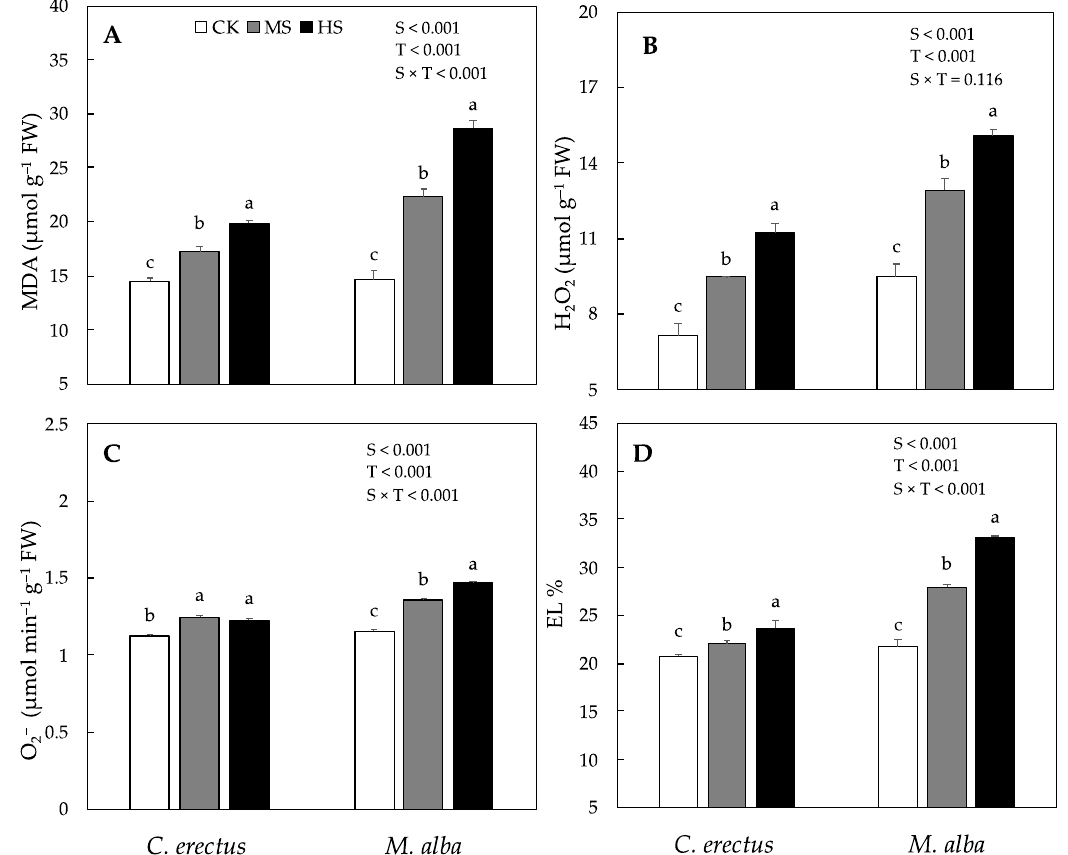
Figure 3. Production of various oxidants, such as hydrogen peroxide, H 2 O 2 ( A ) and superoxide radical, O 2 − ( B ), along with malondialdehyde contents, MDA( C ) and electrolyte leakage, EL% ( D ) under control (CK), Medium (MS) and high (HS) water deficit treatments in C. erectus and M. alba . All the attributes were tested using a two-way ANOVA for species effect (S-effect), treatment (T-effect) and interaction (S × T) effects. All values represent the means ( ± SE) of species in various combinations. Small letters set in bold represent significant difference within each species tested using Dunnett’s test. All the tests were taken to be significant at p <